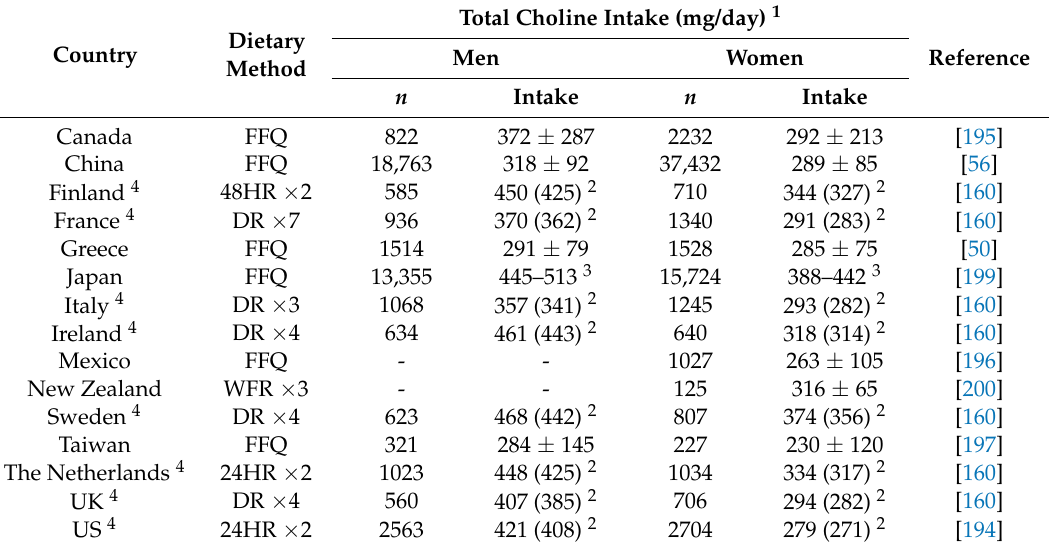
Table 4. Studies reporting on dietary total choline intake in healthy